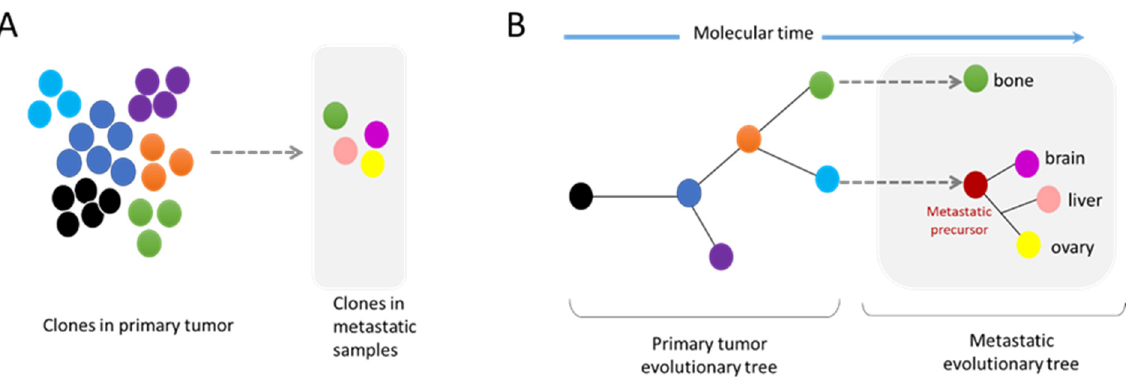
Figure 4. Modes of metastatic dissemination from the primary tumor. ( A ) The primary tumor is composed of a multiclonal population with cells competing between each other. Metastatic tumors are formed by clones found in the primary site, as well as by new independent subclones. ( B ) The phylogenetic tree shows the history of the tumor evolution. Genomic diversity can arise at all steps of tumor progression. Importantly, the metastatic site can be composed of clonal populations found in the primary tumor site or independent subclones.